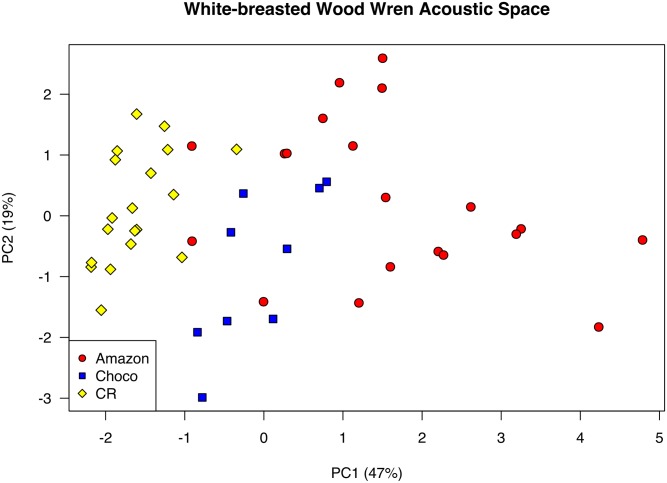
PCA plot of acoustic space.Larger values on PC1 represent songs that are longer, that have more notes (that are shorter) and that cover a wider range of frequencies. Larger values on PC2 represent songs with faster note rates and smaller frequency ranges. Populations, shown in yellow (Costa Rica), red (Amazon) and blue (Chocó), are somewhat differentiated in acoustic space.